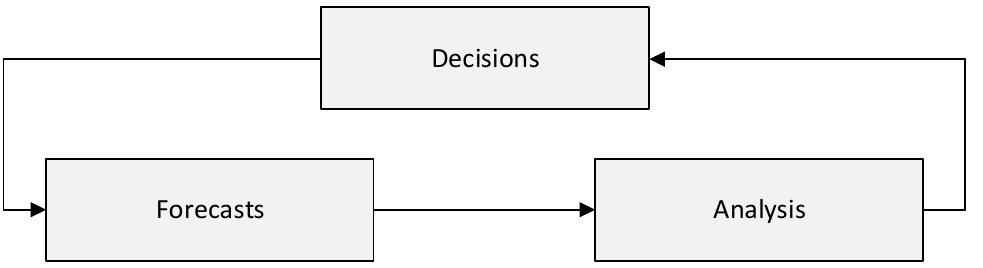
Figure 1. A general planning loop of the planning process for the TEP.